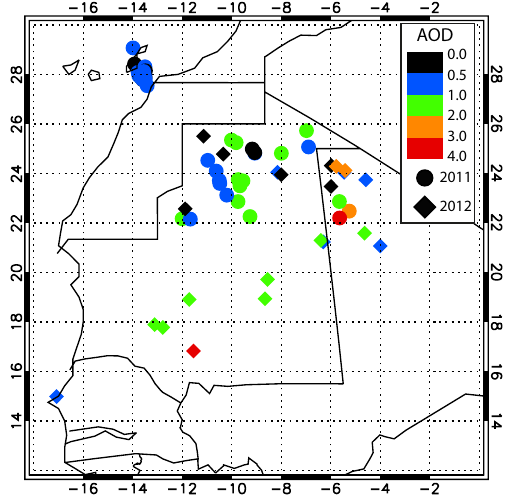
Figure 6. Aerosol optical depths at 550nm measured by the neph- elometer and PSAP on the BAe146 during profiles, represent- ing accumulation-mode 550nm AOD. AODs are an underestimate since they do not include contributions from coarse particles. Cir- cles represent 2011 data, diamonds 2012